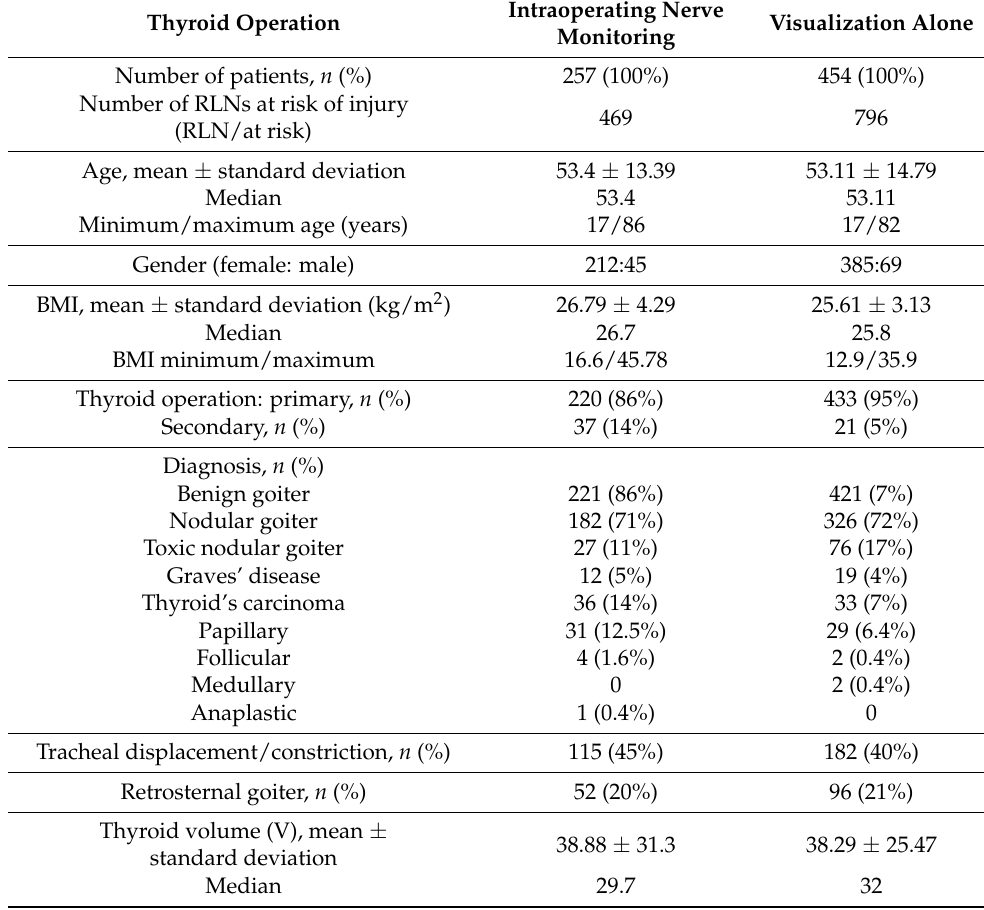
Table 1. Demographic data and clinical characteristics of patients operated with IONM vs.visual RLN identification